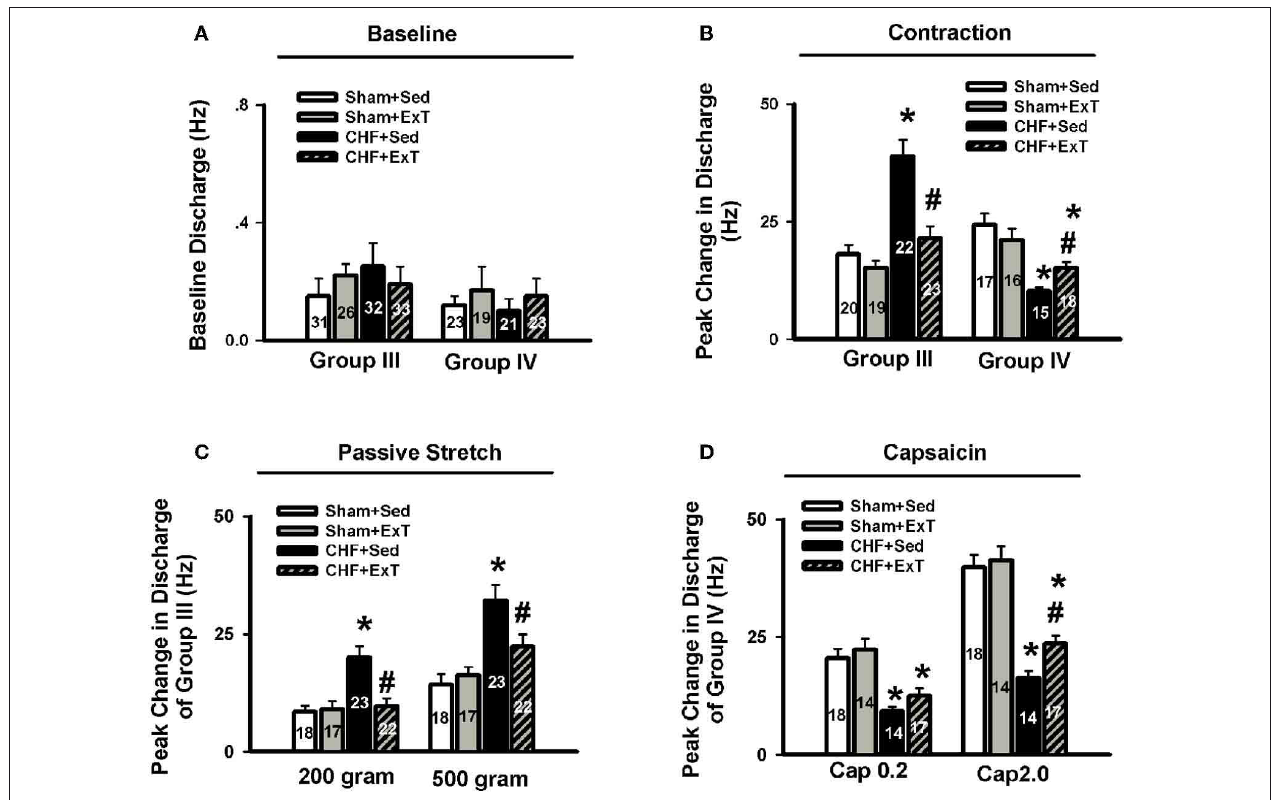
stretch (C) and two doses of capsaicin (D) respectively in Sham + Sed, Sham + ExT, CHF + Sed and CHF + ExT rats. The digit in the bar graph indicates the number of recording fibers. Data are expressed as Mean ± SE. ∗ P < 0 . 05 vs. sham + Sed, # P < 0 . 05 vs. CHF + Sed. [Reprinted from Wang et al. (2012). Copyright @ 2012 American Heart Association. Used with